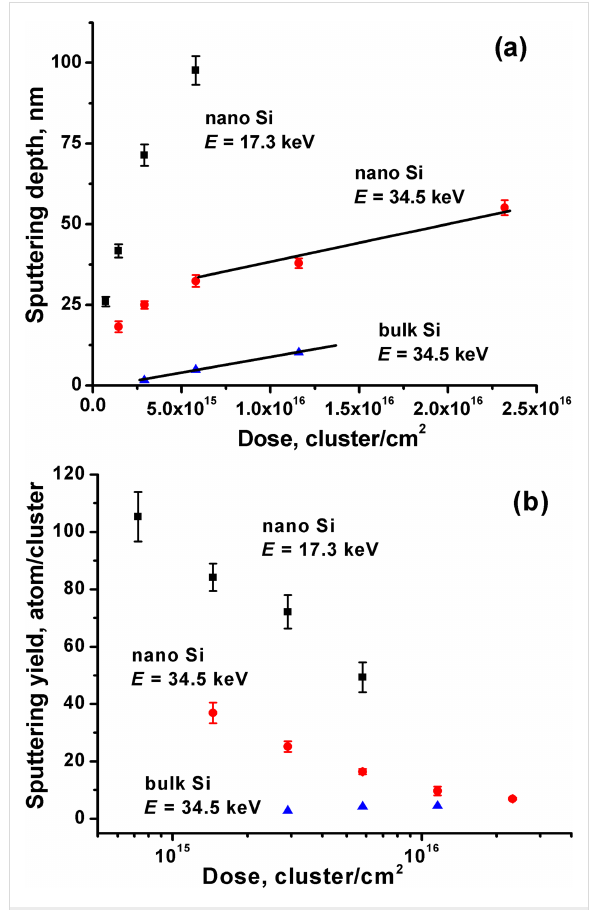
Figure 3: The sputtering depth (a) and sputtering yield (b) depen- dence on the ion dose of the nanopowder Si irradiated at different energies and bulk Si irradiated at 34.5